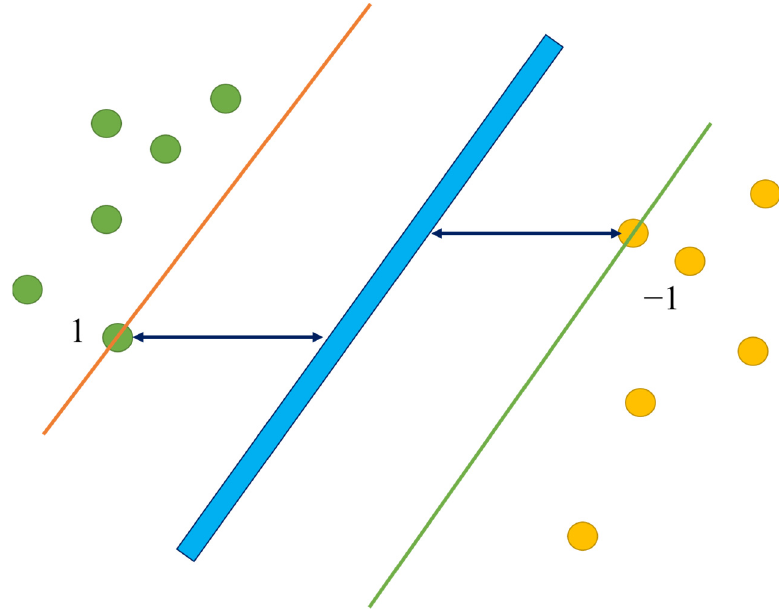
Figure 6. Schematic diagram of support vector machine principle.